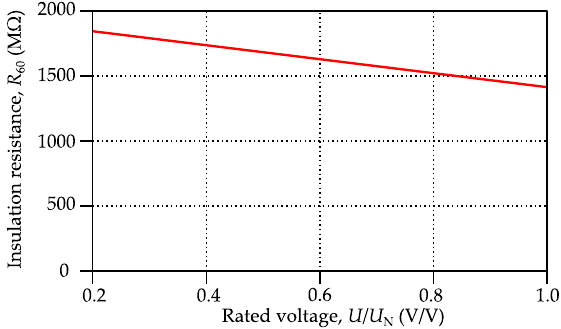
Figure 10. Characteristic R 60 = f( U ).